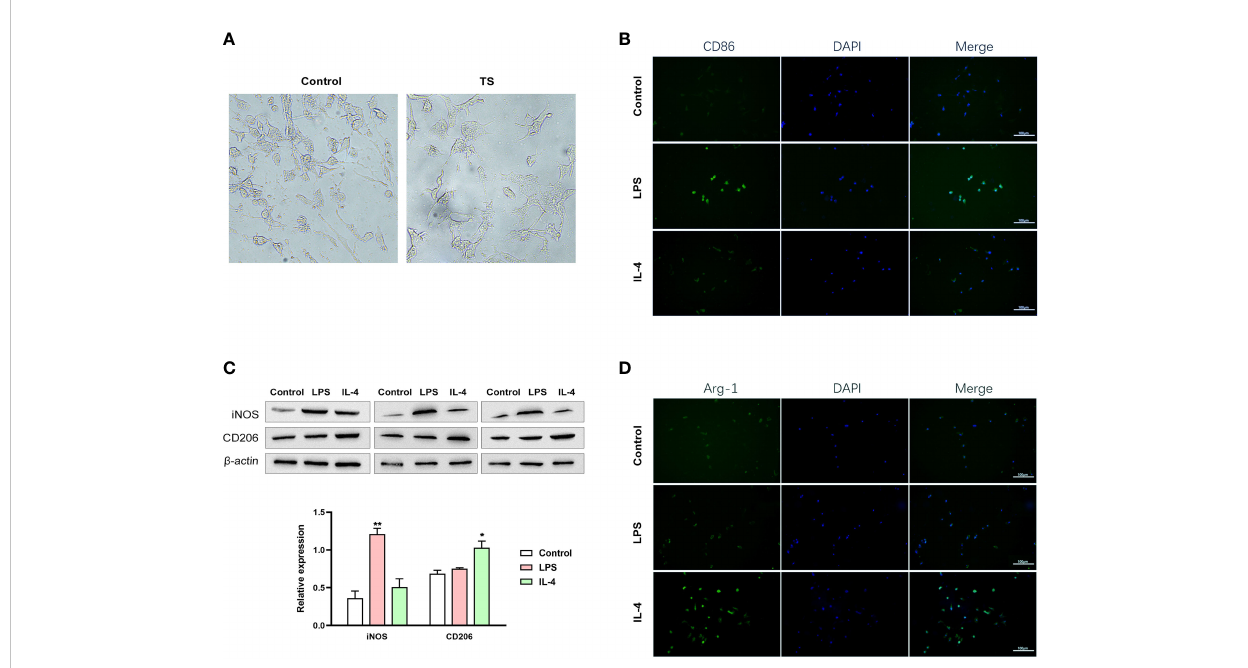
FIGURE 3 Different groups of microglia. (A) The morphology of microglia in two groups. (B – D) Normal microglia are treated using lipopolysaccharide (LPS) (towards the M1 phenotype) or IL-4 (towards the M2 phenotype). (B) LPS treatment effectively induced a M1 polarization of microglia (veri fi ed by the IF of the marker CD86). (C) IL-4 triggered a M2 polarization (veri fi ed by the IF of the marker Arg-1). (D) Western blot analysis of iNOS and CD206 expression in two treatment groups. *P <0.05, **P